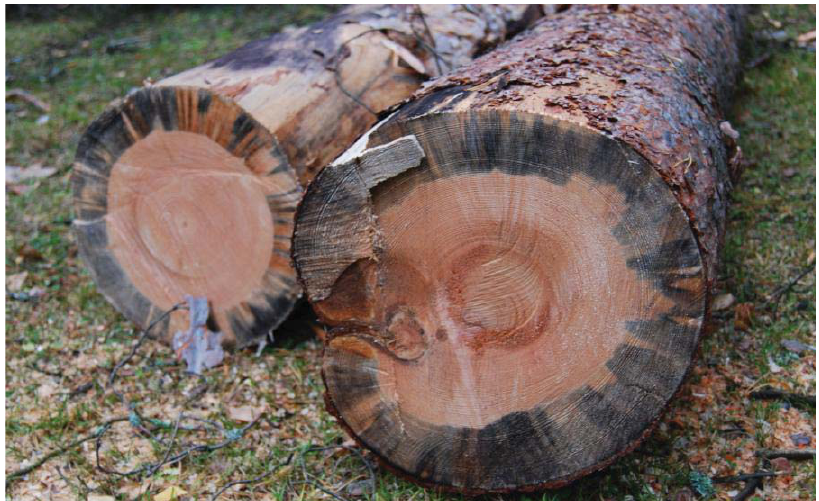
Figure 1. Blue stain caused by ophiostomatoid fungi in Pinus sylvestris .